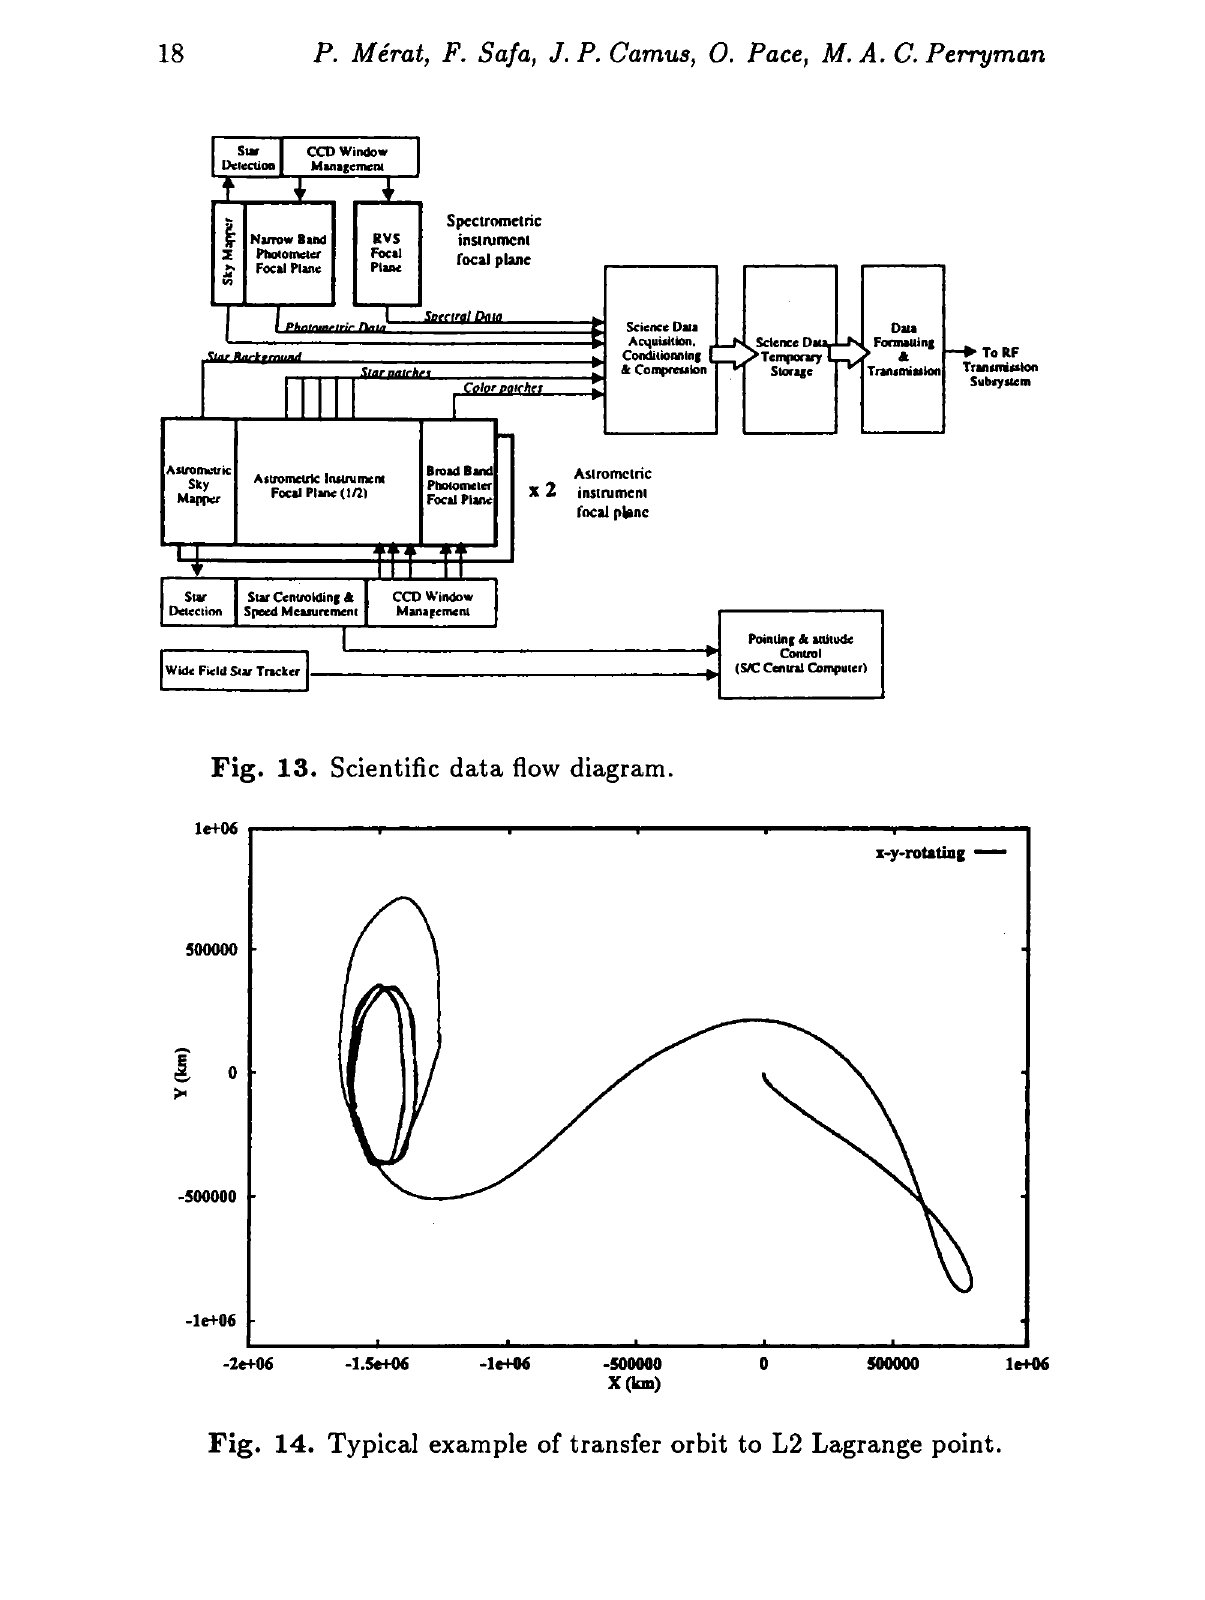
Fig. 14. Typical example of transfer orbit to L2 Lagrange